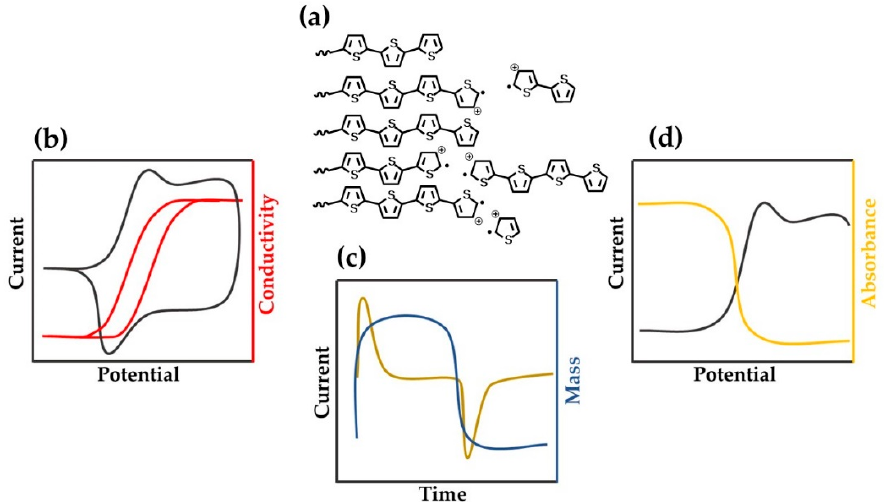
Figure 2. Schematic illustration of the ( a ) long chain propagation catalyzed by solid-state redox processes and different electrochemical and spectroelectrochemical responses obtained during the electrochemical characterization of CP; the possible physico-chemical response obtained during ( b ) potentiodynamic and conductance measurements, ( c ) potentiostatic and gravimetric analysis, and ( d ) spectroelectrochemical experiments.